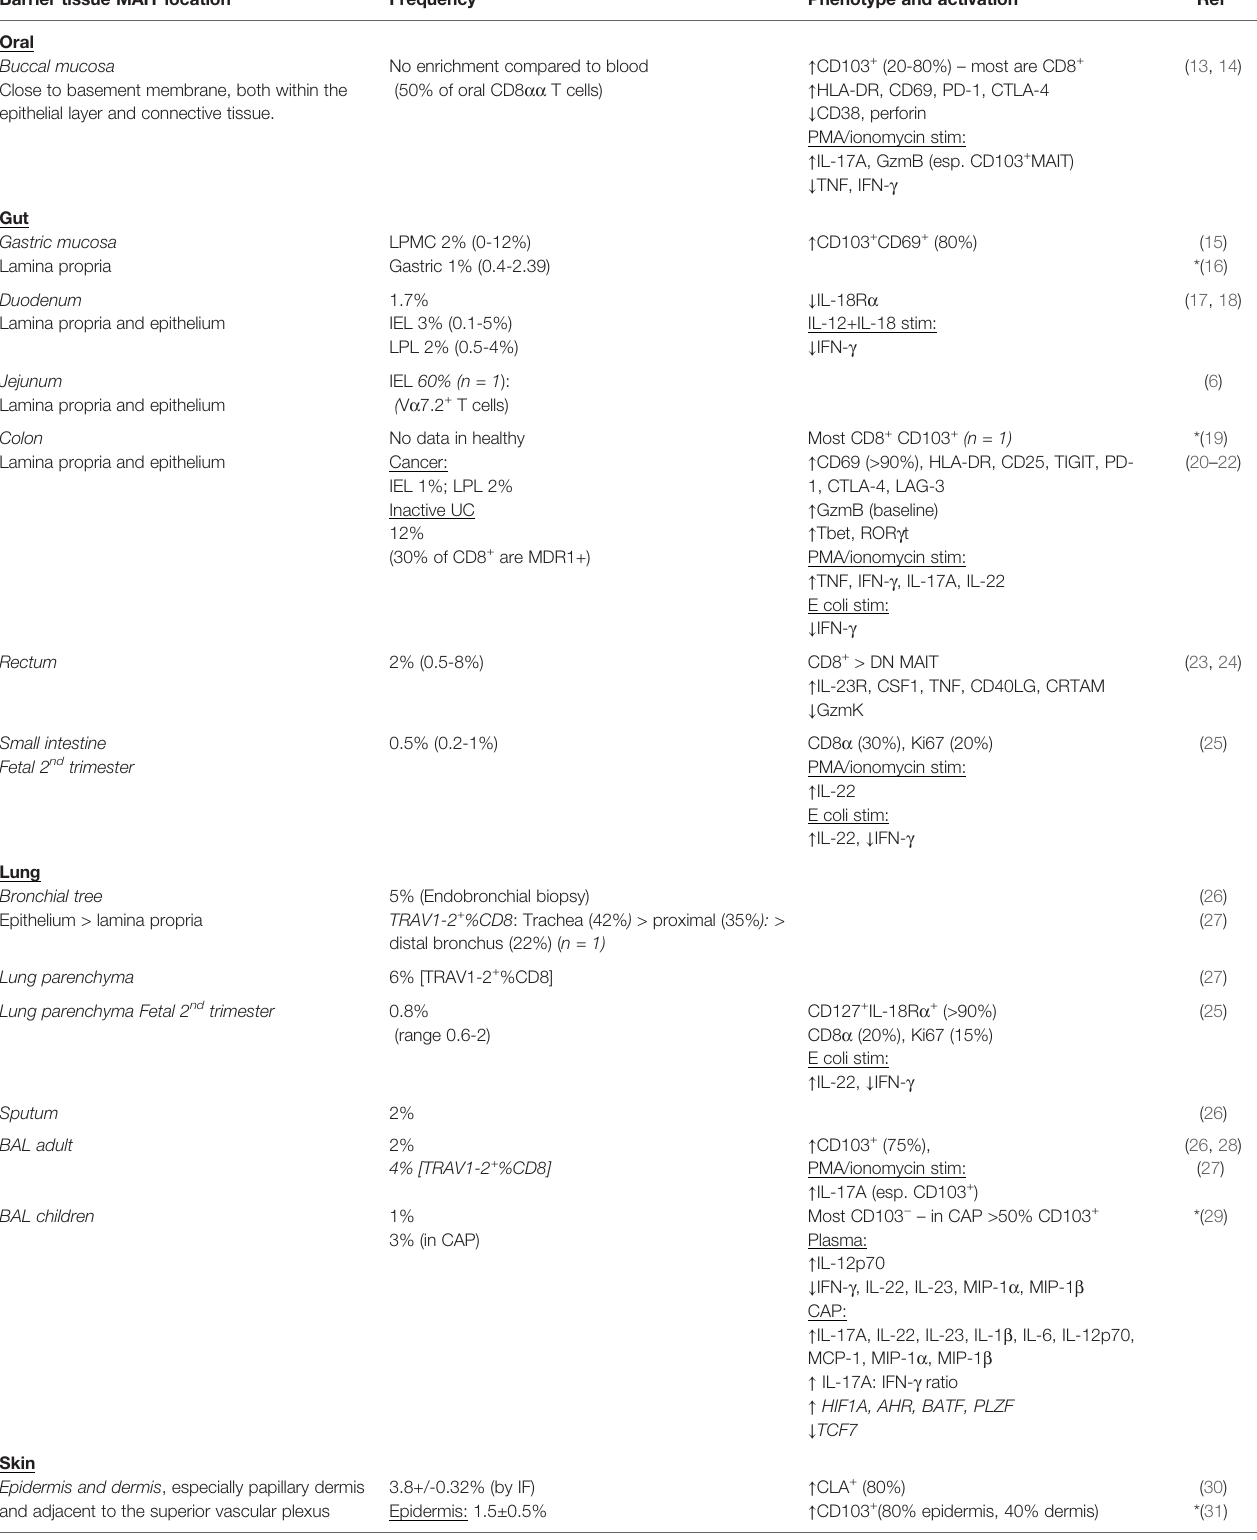
TABLE 1 | MAIT cells in healthy human barrier